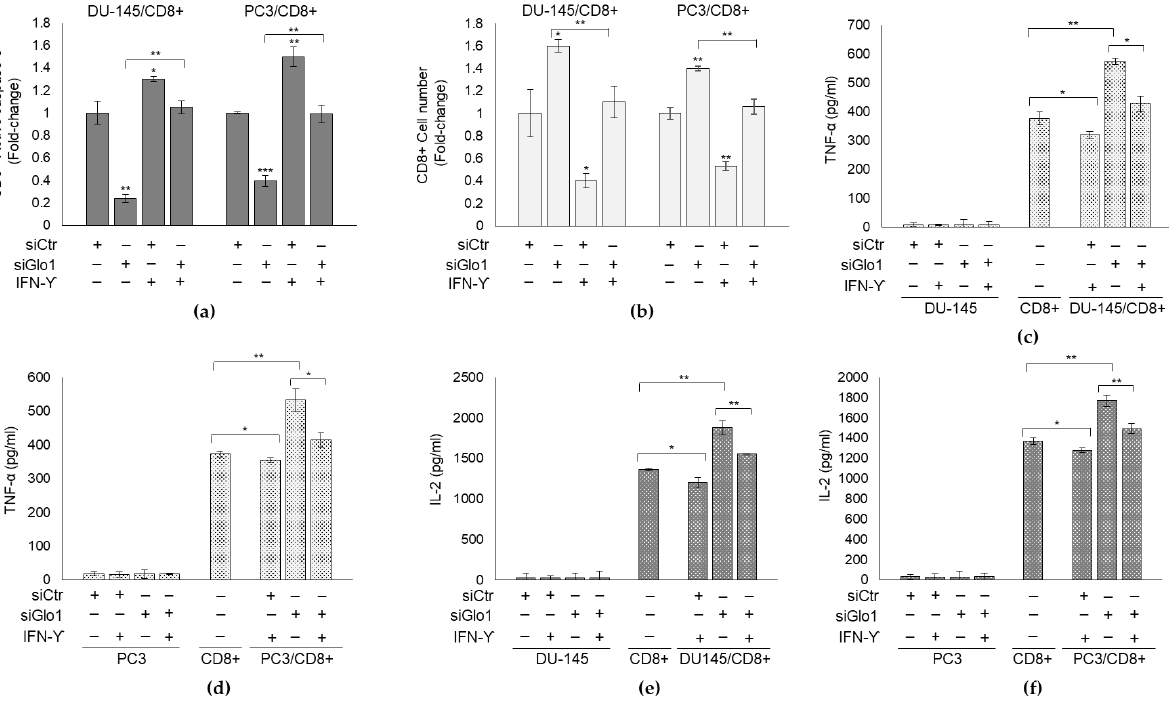
Figure 6. Glyoxalase 1 (Glo1)/MG-H1/PD-L1 axis is involved in mPCa immunosurveillance escape. DU145 and PC3 cells transiently transfected with Glo1 small interfering RNA (siGlo1) or control non-targeting small interfering RNA (siCtr) were co-cultured with CD8+ cytotoxic T cells and exposed to 5 ng/mL IFN- γ for 8 h. ( a ) CD8+ apoptosis was evaluated by active caspase-3 expression, with a specific ELISA kit, ( b ) CD8+ cell number was measured by cell counting, ( c , d ) TNF-α and ( e , f ) IL-2 secretion by CD8+ cells in the culture medium was detected by specific ELISA kits. The histograms indicate mean ± SD of three different cultures, and each was tested in duplicate. (−) untreated and (+) treated cells. * p < 0.05, ** p < 0.01; *** p 0.001.